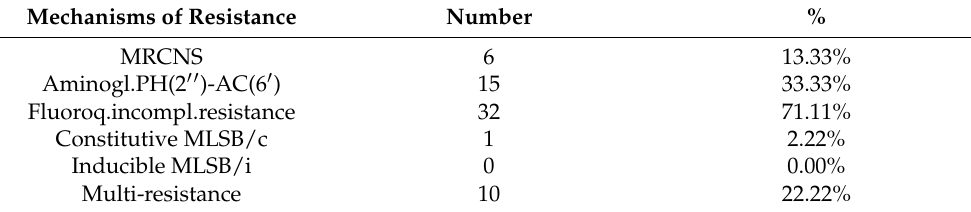
Table 4. Phenotypic detection of various mechanisms of resistance.